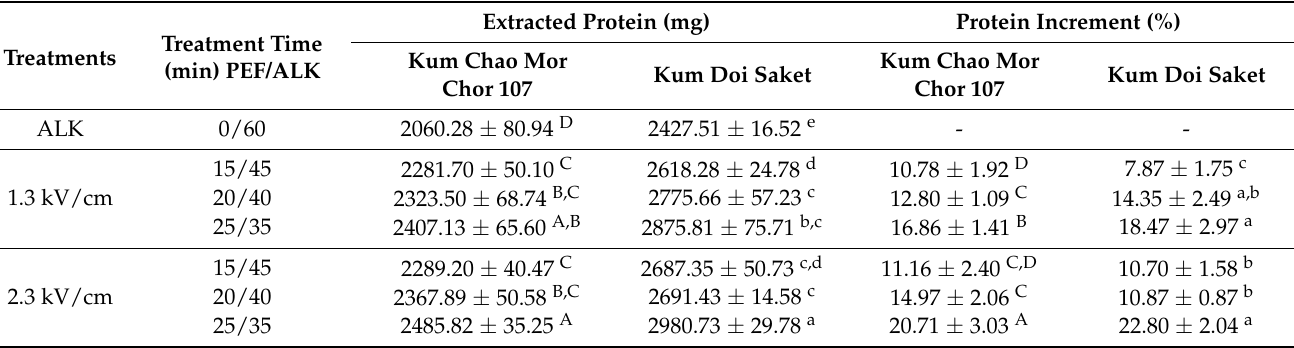
Table 1. Extracted protein derived from ALK and PEF treatments.